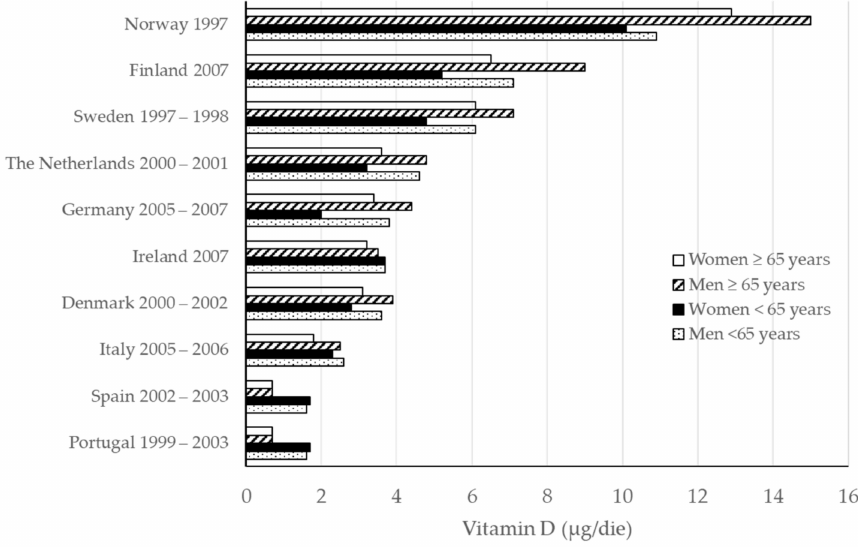
Figure 2. Vitamin D intake ( µ g/day) in adults living in some European countries (modified from